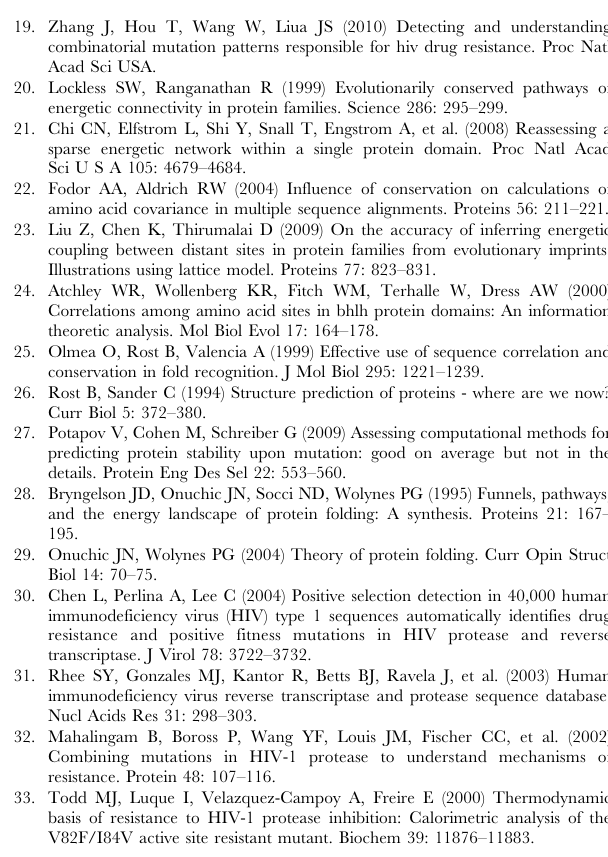
combination they are most significantly associated with. Drug combinations are listed in order of treatment. The test of statistical association between drugs and electrostatic mutation patterns is based on the the Stanford database [31] (SI Methods). The proportion of sequences with the mutation pattern and exposed to a specific drug was compared to the proportion of sequences with the same mutation pattern but exposed to no drugs. The null hypothesis is that that the two proportions are equal, and the p- value to test the significance of this hypothesis is listed alongside the drug combination. NFV: Nelfinavir, IDV: Indinavir, SQV: Saquinavir, RTV: Ritonavir, APV: Amprenavir. The acronym PI, protease inhibitor, is used in the Stanford database when the drug was unknown. The D 30 N , N 37 D , Q 61 E , N 88 D pattern is not significantly associated with any drug combination. Table S2 Prediction of novel electrostatic mutation patterns. Shown are 25 electrostatic mutation patterns with the highest probabilities under the pair correlation model that are not observed in the Lee database [30]. P 2 is the probability of the sequence under the pair correlation model, N LEE is the number of times the mutation pattern was found in the Lee database [30], N ST is the number of times the mutation pattern was found in the Stanford database [31]. If the sequence is found in the Stanford database, it may be significantly associated with specific drugs combinations. The drug combinations listed are in order of treatment and have strong p-values of association with the mutation pattern. The test of statistical association between drugs and electrostatic mutation patterns is described in SI Methods.